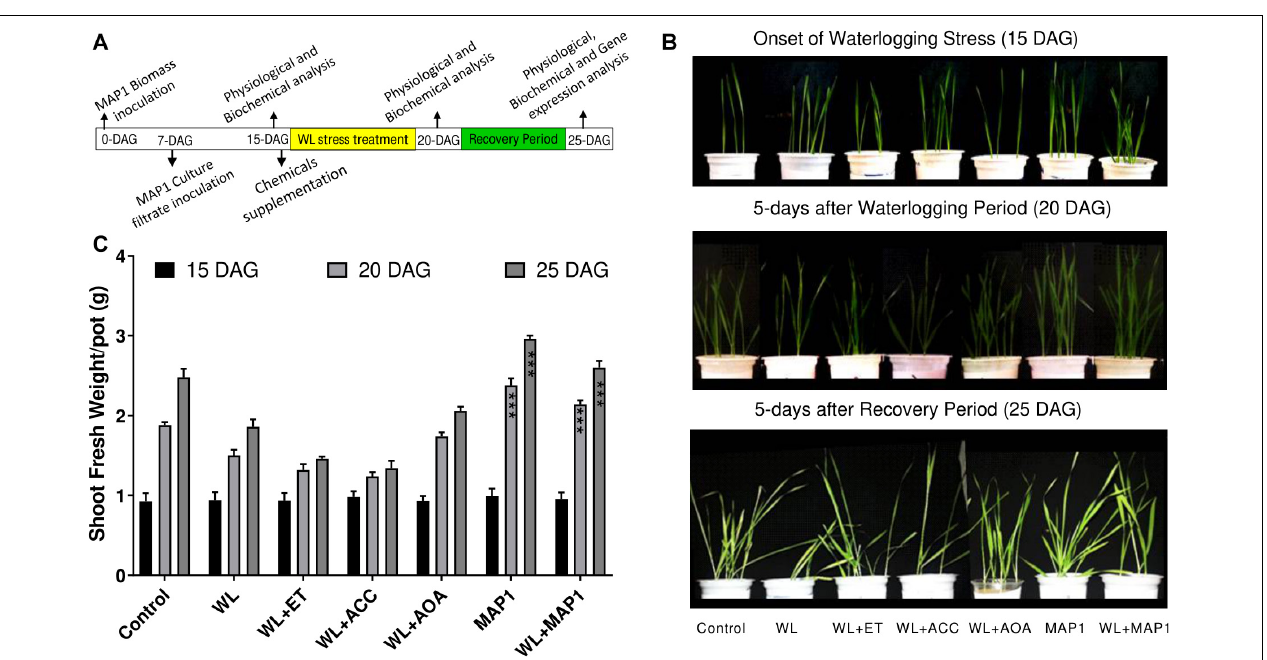
FIGURE 3 | Effect of the fungal strain MAP1 on wheat plant growth. (A) Schematic representation of the wheat seedling bioassay experimental setup. Uniformly germinated wheat seedlings were transferred to the soil pots pre-mixed with MAP1 biomass. Seven-day-old wheat seedlings were inoculated with MAP1 culture filtrate. Fifteen-day-old seedlings were irrigated (8 h before onset of flooding treatment) with ACC, ethephon, and AOA. Fifteen-day-old plants were exposed to waterlogging stress for 5 days continuously and were subjected to a recovery period of further 5 days. Note the arrows indicating the time point of experimental activities. (B) Phenotypic analysis of wheat seedlings, with and without MAP1 inoculation exposed to WS and chemical supplementation. (C) Fresh weight of wheat seedlings compared to control. Quantitative data represent means ± SD of three independent experiments and at least 10 technical replicates each. The asterisks indicate a significant difference compared to untreated control ( ∗∗∗ p ≤